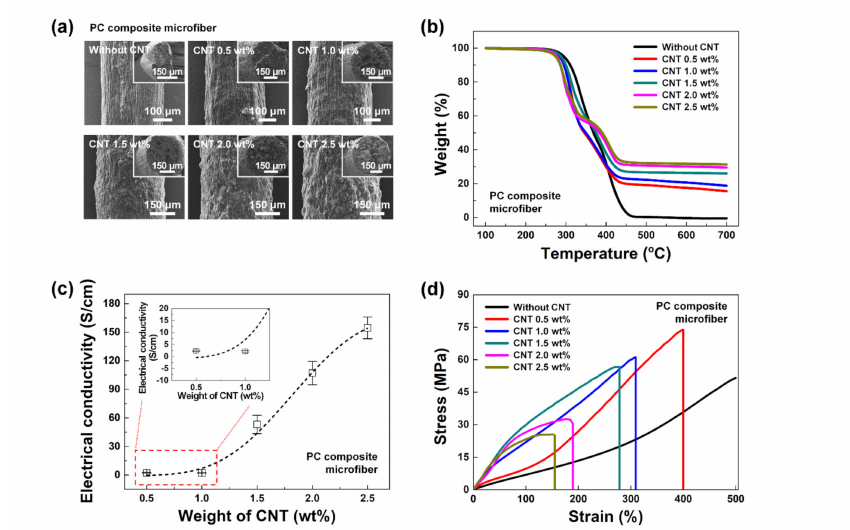
Figure 2. Morphology, thermal, electrical, and mechanical properties of PC composite microfibers with di ff erent CNT contents (0, 0.5, 1.0, 1.5, 2.0, and 2.5 wt%): ( a ) FESEM images, ( b ) TGA curves, ( c ) conductivities, and ( d ) stress–strain